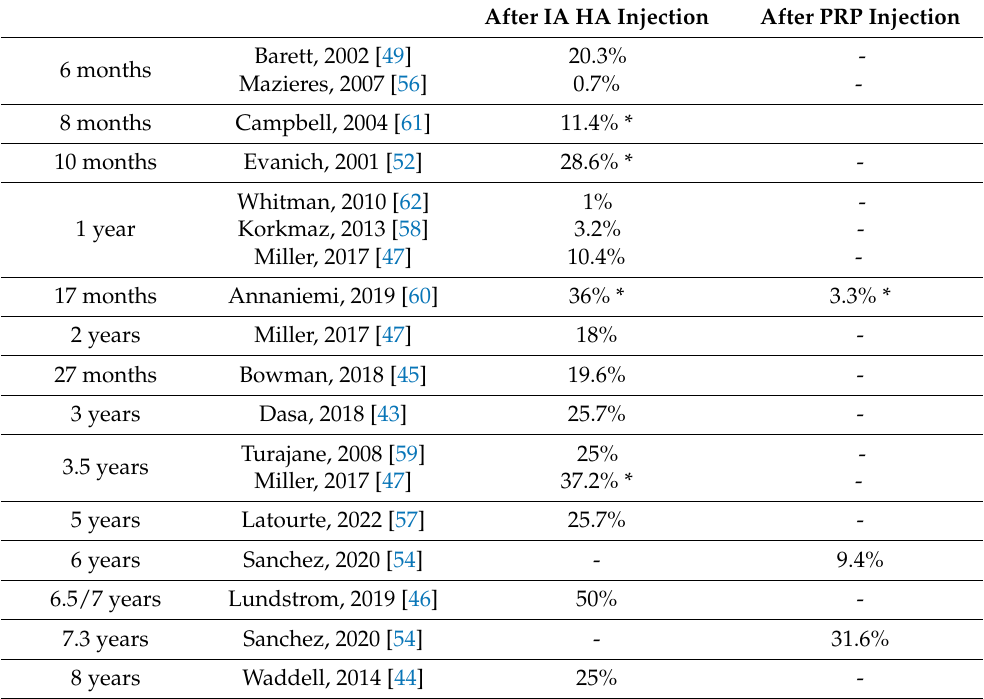
Table 3. Prevalence of TKA after IA